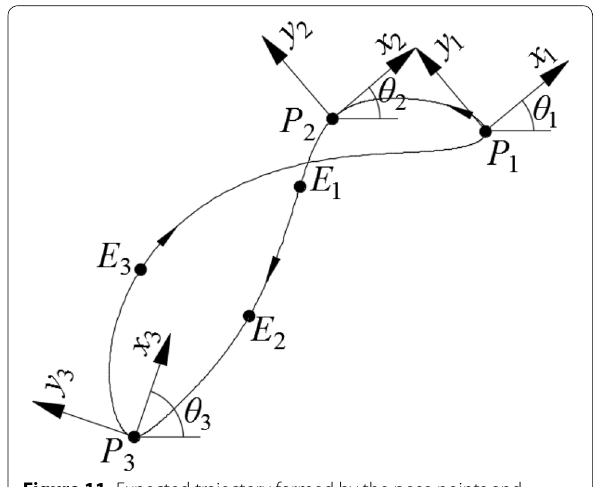
Figure 11 Expected trajectory formed by the pose points and control